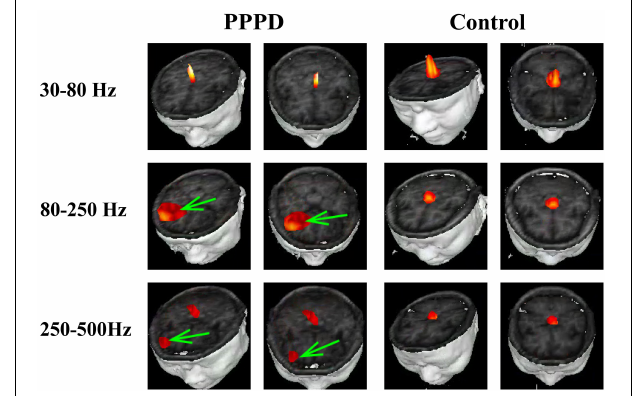
FIGURE 2 | Typical distribution of neuromagnetic source localization in 30–500 Hz frequency bands in PPPD patients and controls. Green arrows indicate the significant difference in source localization in PPPD patients compared with the